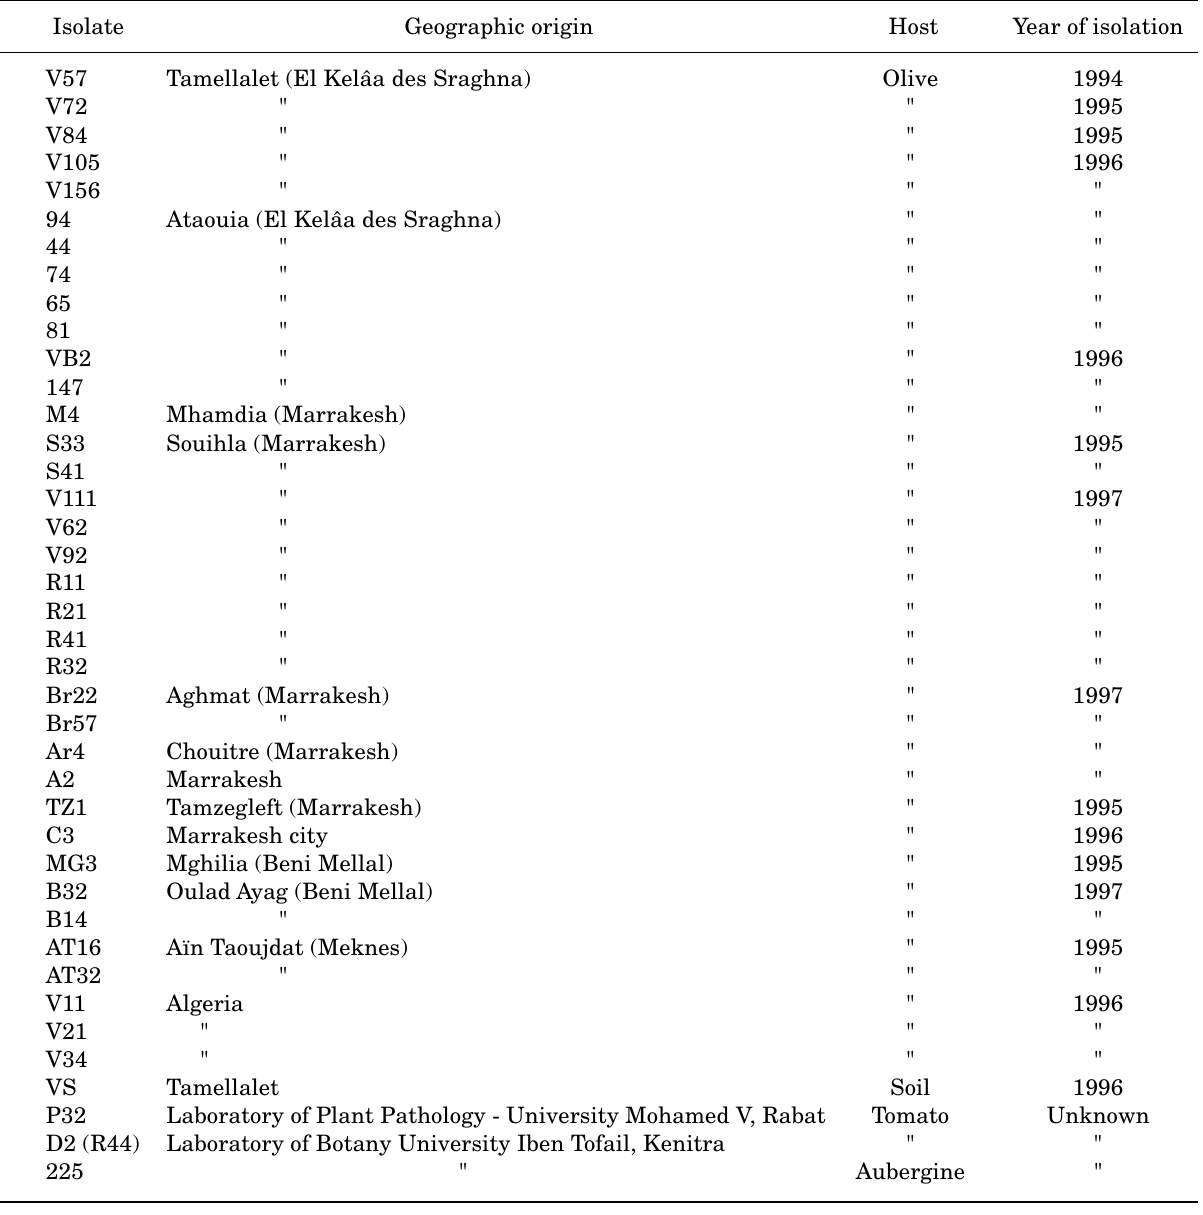
Table 1. Isolate designation, geographic origin, host and year of isolation of Verticillium dahliae isolates used in the study.